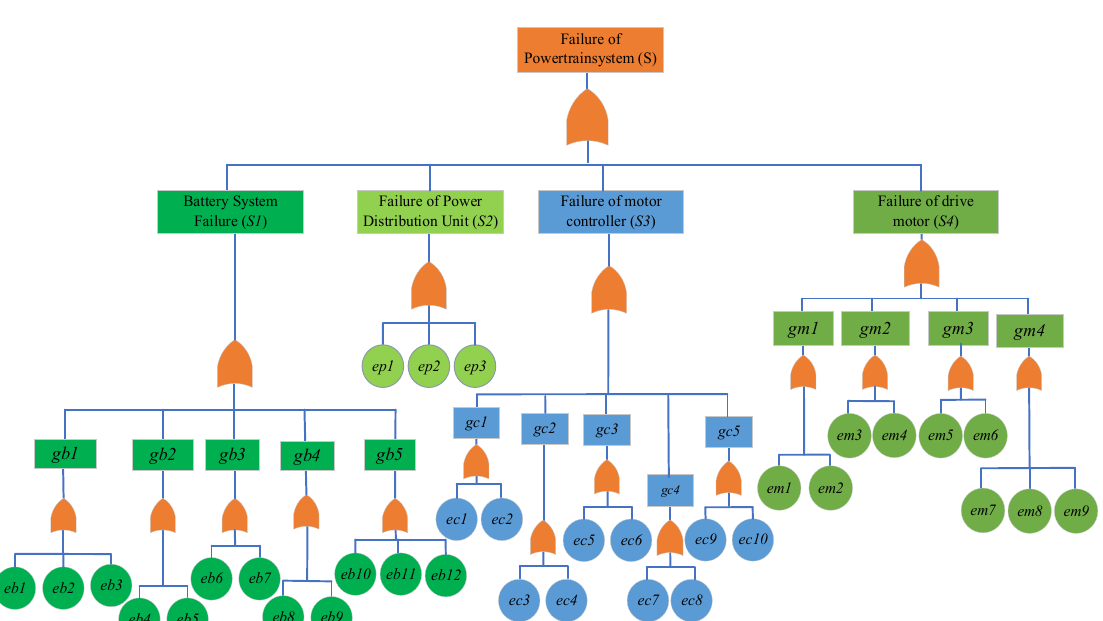
Figure 6. Fault tree model of BEV powertrain system.